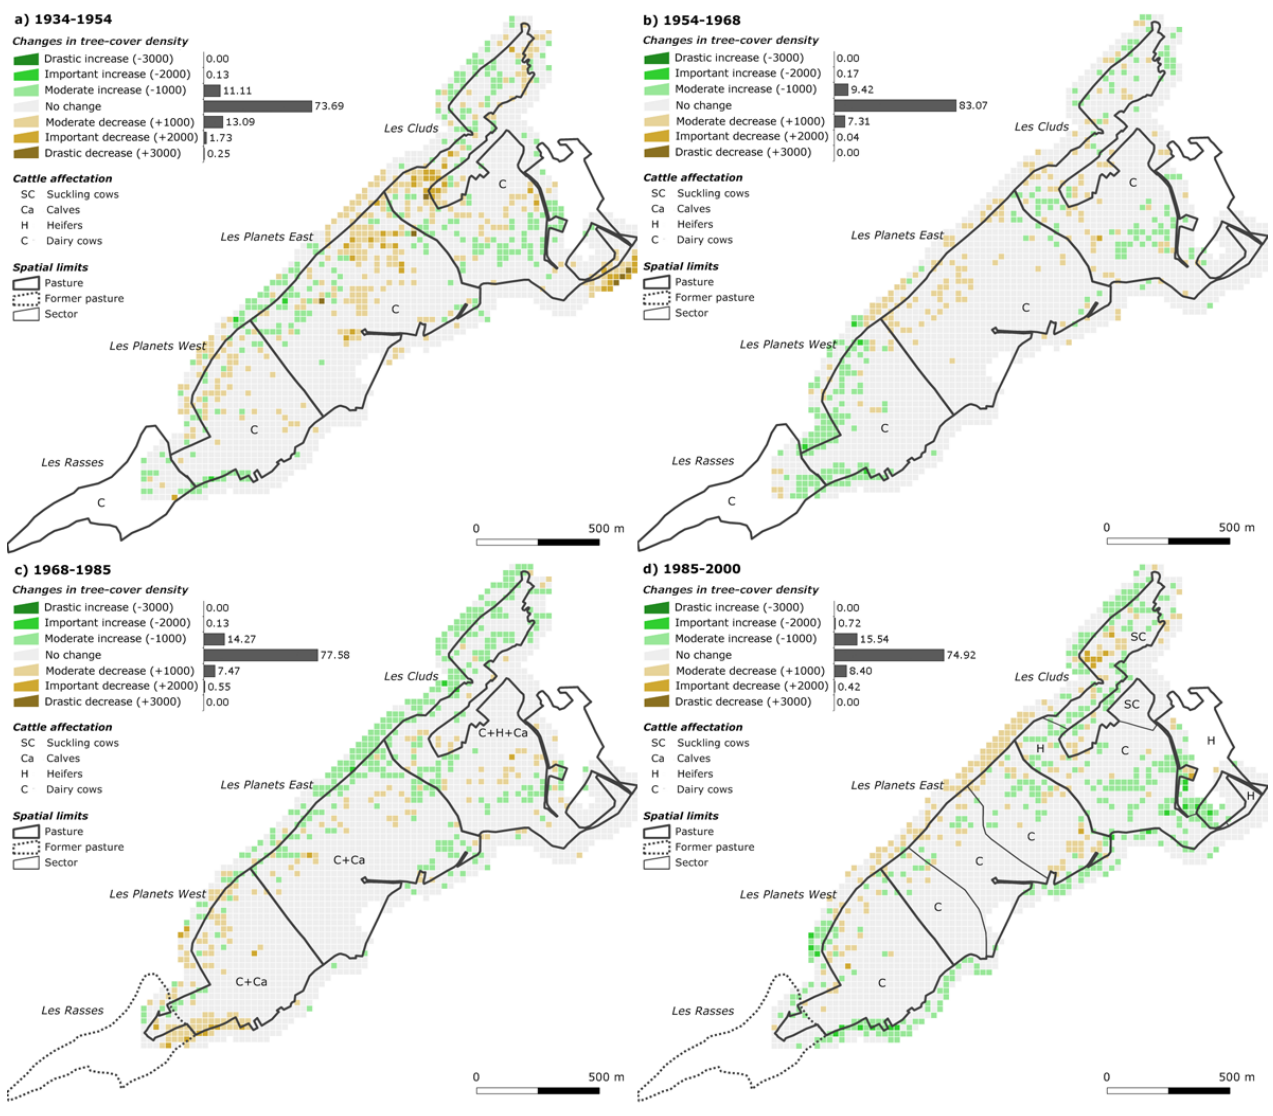
Fig. 5 . Evolution in management structures and in tree-cover categories between 1934 and 2000 in